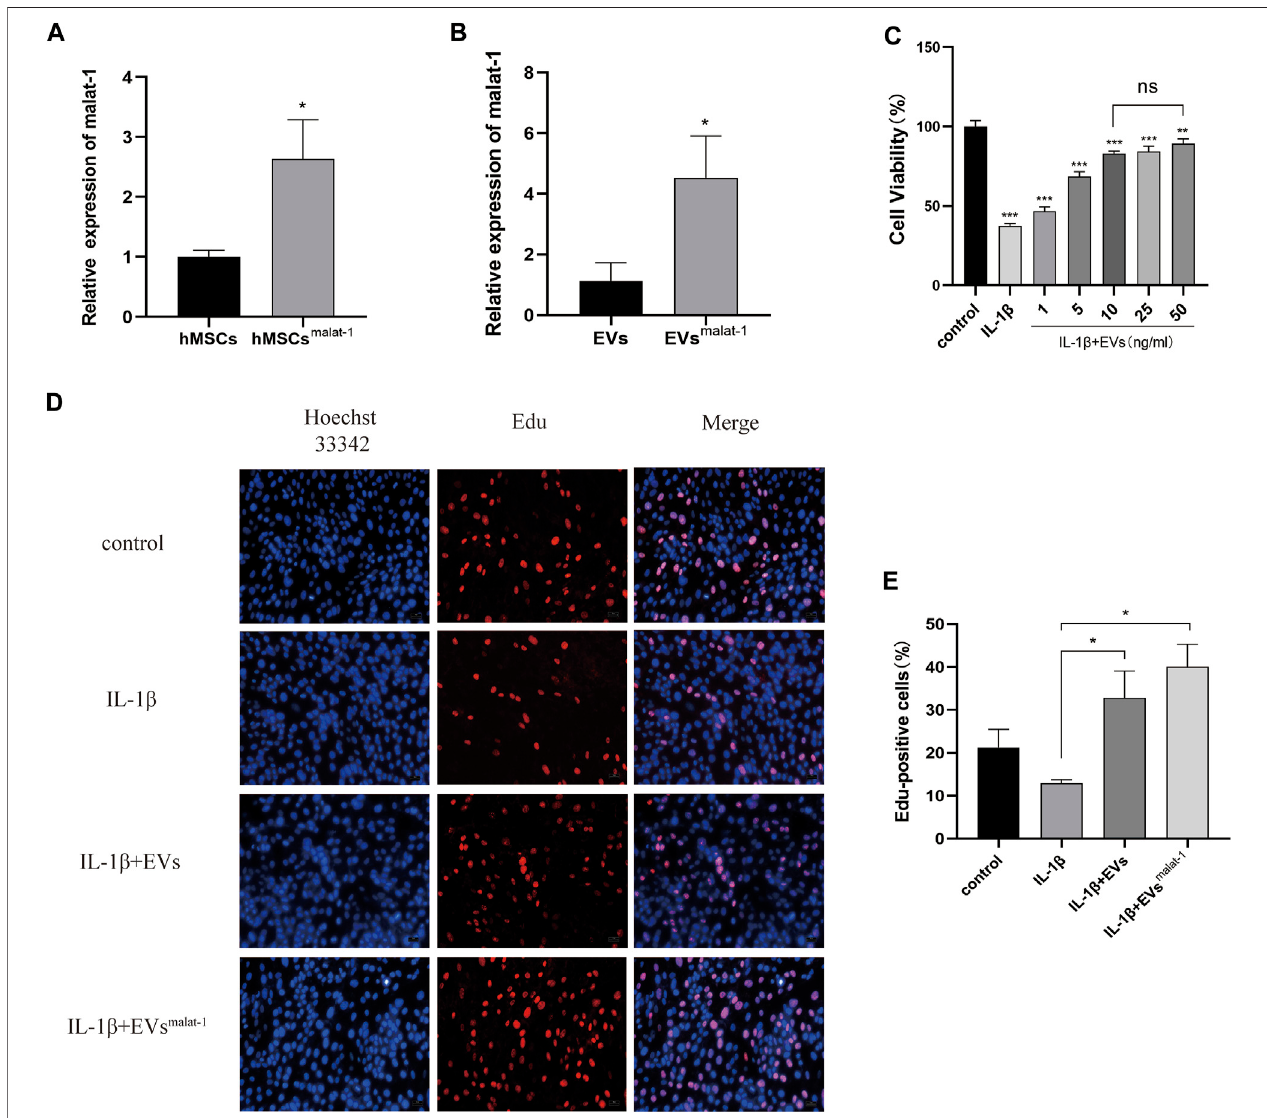
FIGURE3|(A) TheexpressionoflncRNAmalat-1wereanalyzebetweenhMSCsandhMSCs over-malat − 1 byqRT-PCR, n (cid:2) 3,* p < 0.05,t-test. (B) Theexpressionof lncRNAmalat-1in twoEVsanalyzedbyqRT-PCR,n (cid:2) 3, * p < 0.05, t-test. (C) Cell viabilityofchondrocytes treated withdifferentconcentrations ofEVs byCCK-8assay. n (cid:2) 3, * p < 0.05, one-way ANOVA (D) and (E) Edu assay was performed to detect proliferation of chondrocytes, n (cid:2) 3, * p < 0.05, one-way ANOVA.